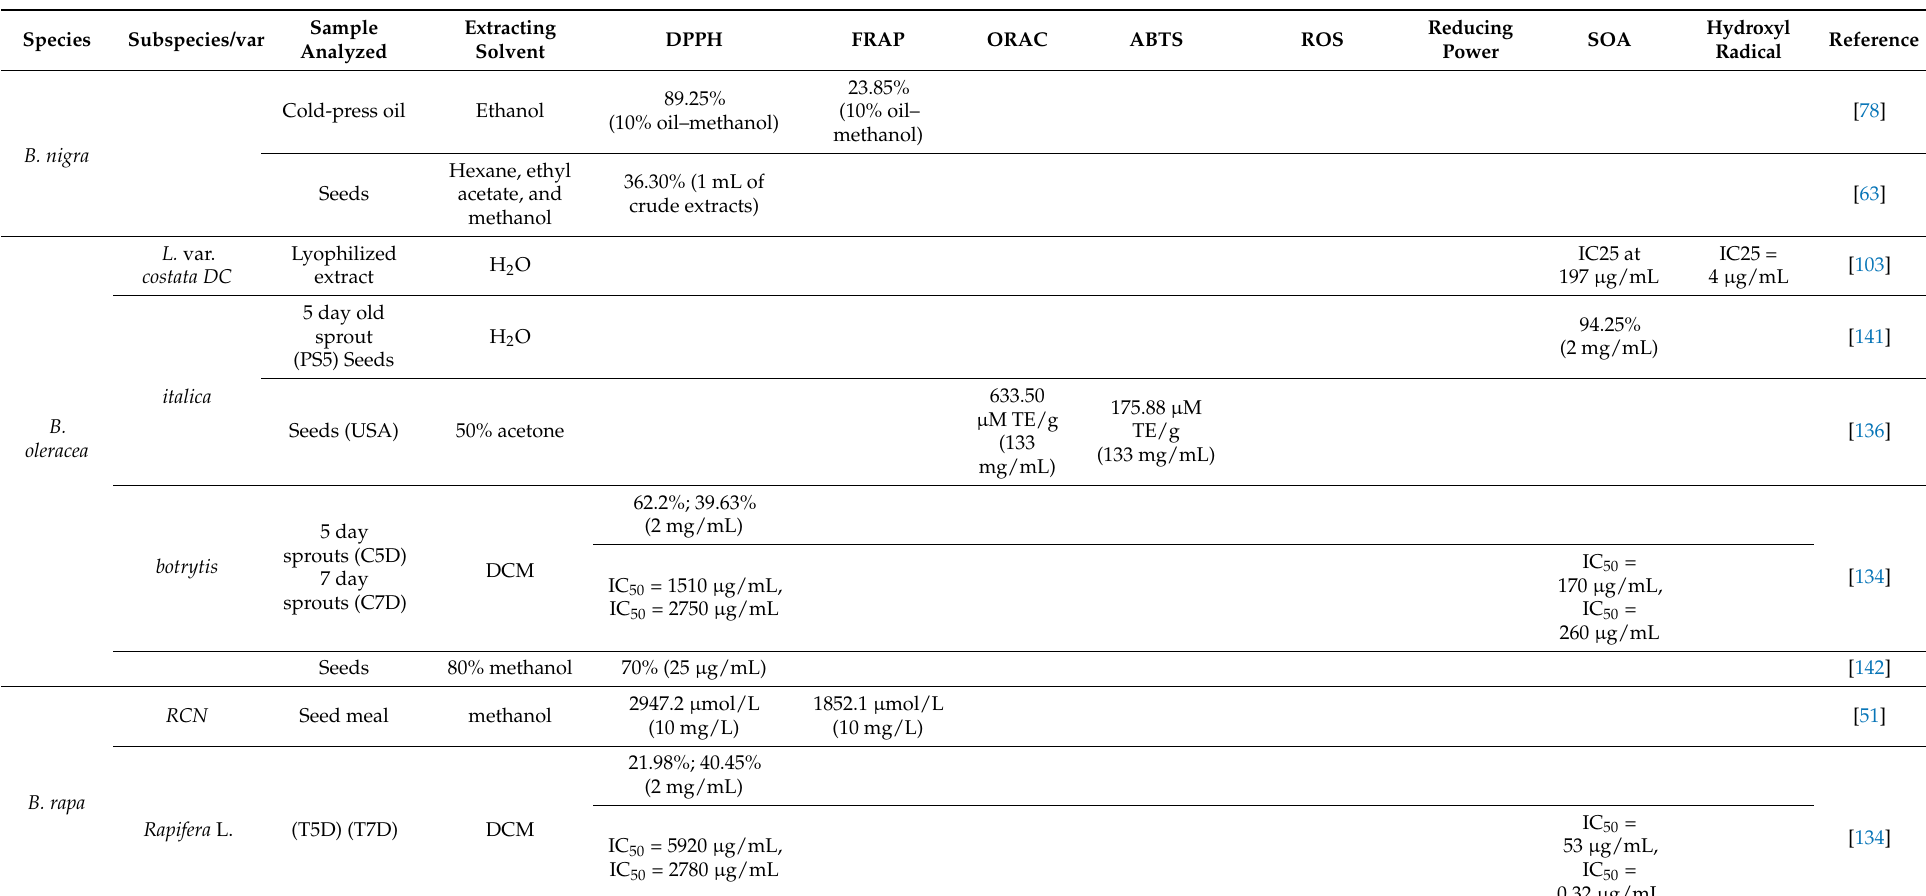
Table 5. Study on antioxidant activity of different Brassica species